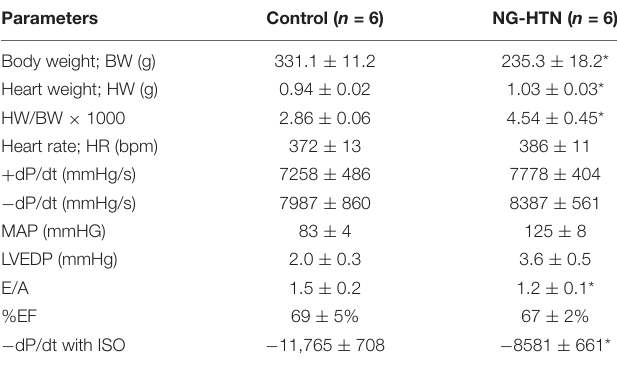
TABLE 1 | Characteristics of Control and NG-HTN rats used in the studies.